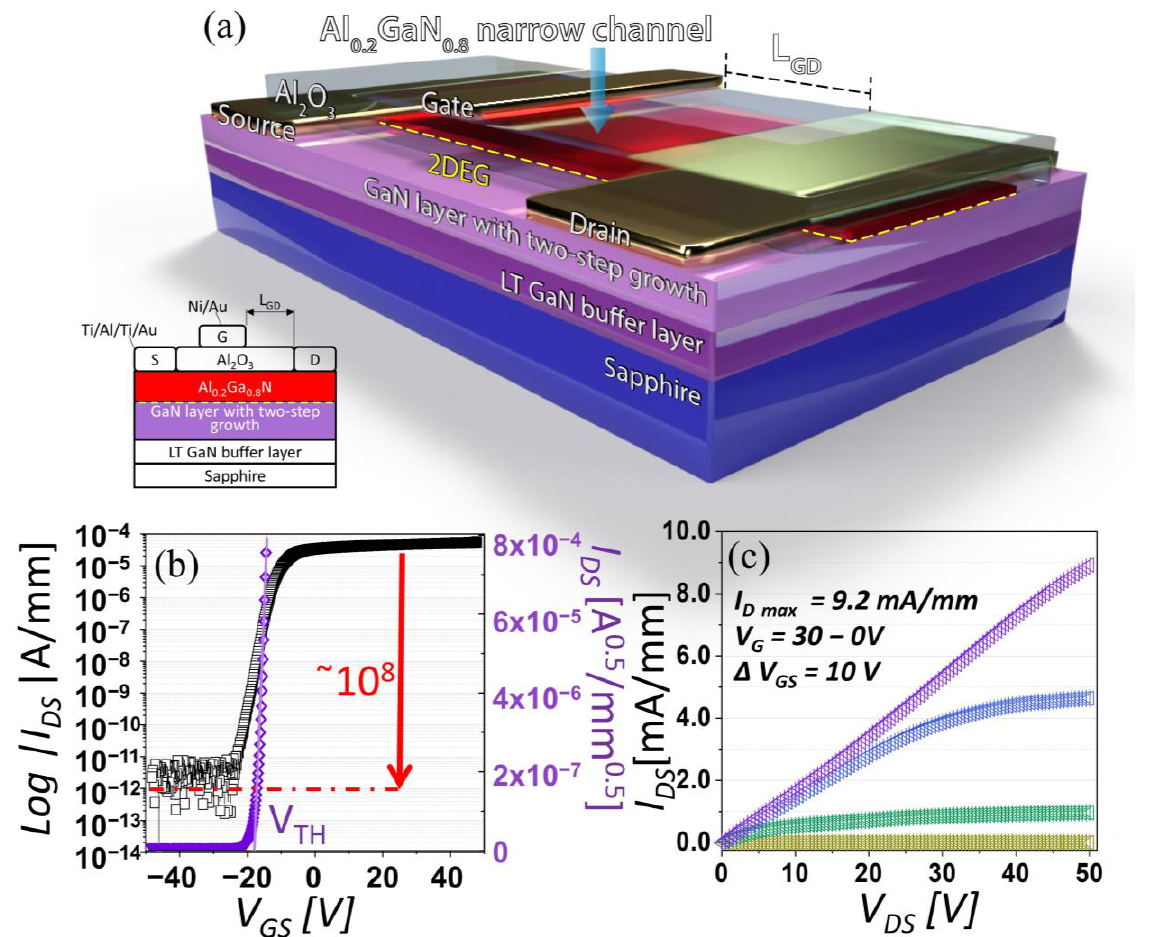
Figure 3. ( a ) Diagram of an Al 2 O 3 /AlGaN/GaN HEMT device with 2DEG horizontal channel underneath the source and drain. ( b ) Log scale I DS – V GS and ( c ) typical I DS – V DS and characteristics of L GD of 17 μm.